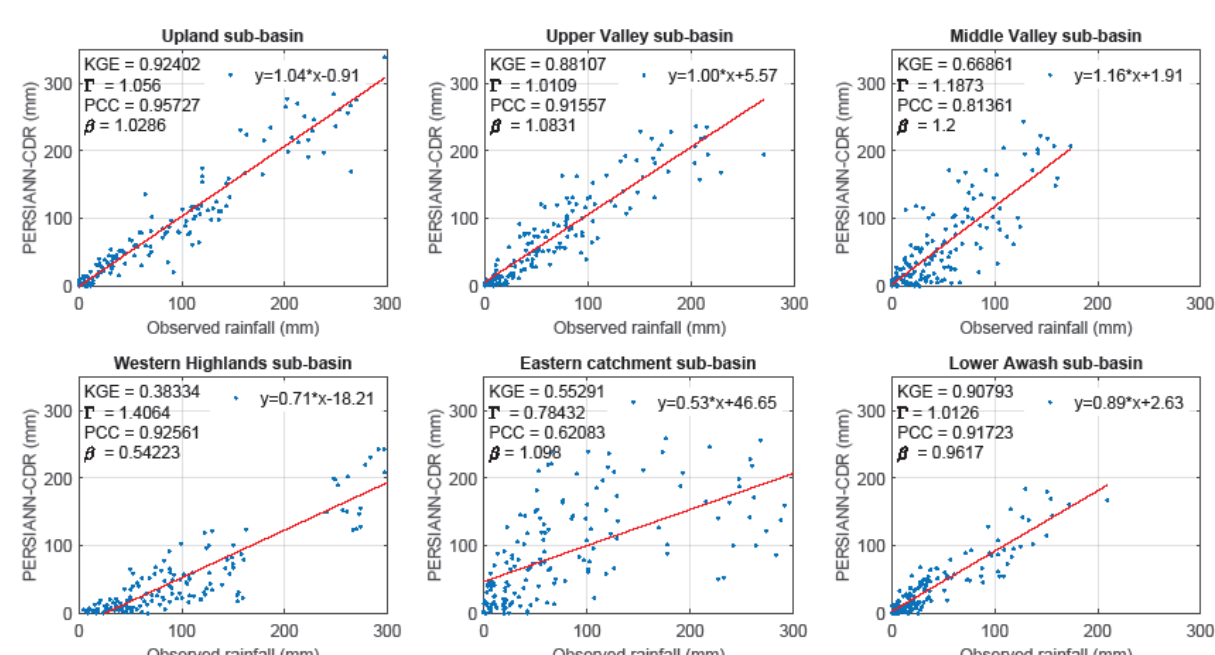
Figure A2. Comparison of PERSIANN-CDR with GROS.